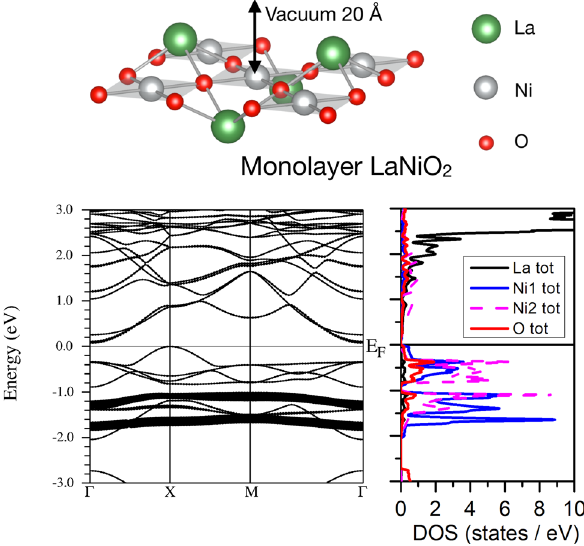
Figure 4. Top panel. Structure of a LaNiO 2 monolayer of the type used for the calculations discussed in the text. Bottom left panel. GGA band structure of the LaNiO 2 monolayer with AF ordering of the Ni atoms, showing only one spin channel. The Ni- d z 2 states are highlighted for both Ni atoms (a Hund splitting can again be observed between them). The O- p bands (not shown) start to appear below Bottom right panel. Corresponding La, O and Ni atom-resolved density of states (both Ni atoms have opposite